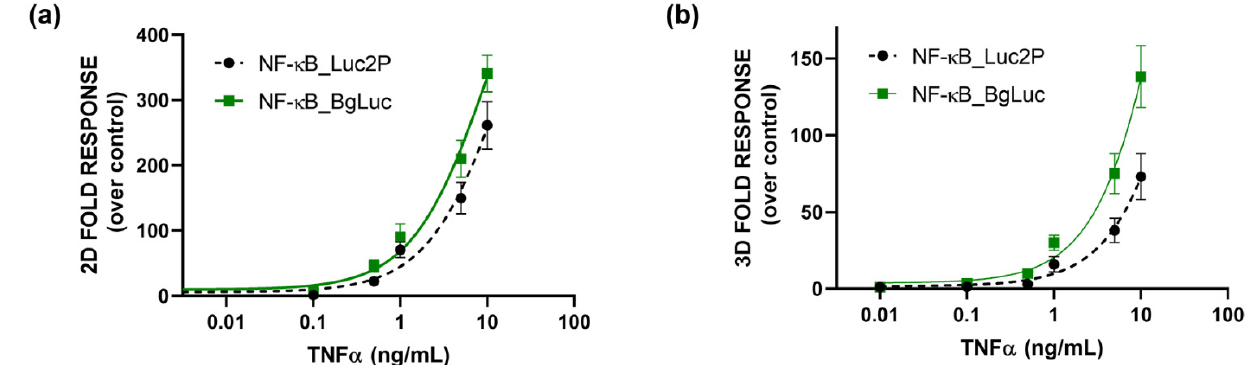
Figure 5. Dose-response curves obtained in ( a ) 2D or ( b ) 3D cell-based assays. HEK293T cells were incubated for 5 h at 37 °C with the TNF α , using BgLuc (solid line) and commercial Luc2P (dotted line) as reporters under the control of NFkB -response element. BL measurements were obtained after the addition of BrightGlo substrate as described in the Materials and Methods section. The experiment was performed in triplicate and repeated at least three times.